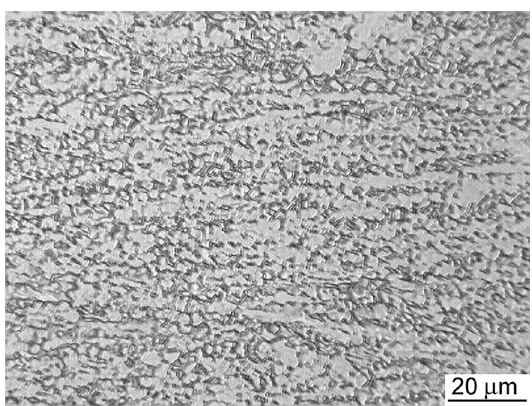
Figure 1. Microstructure of the received material.